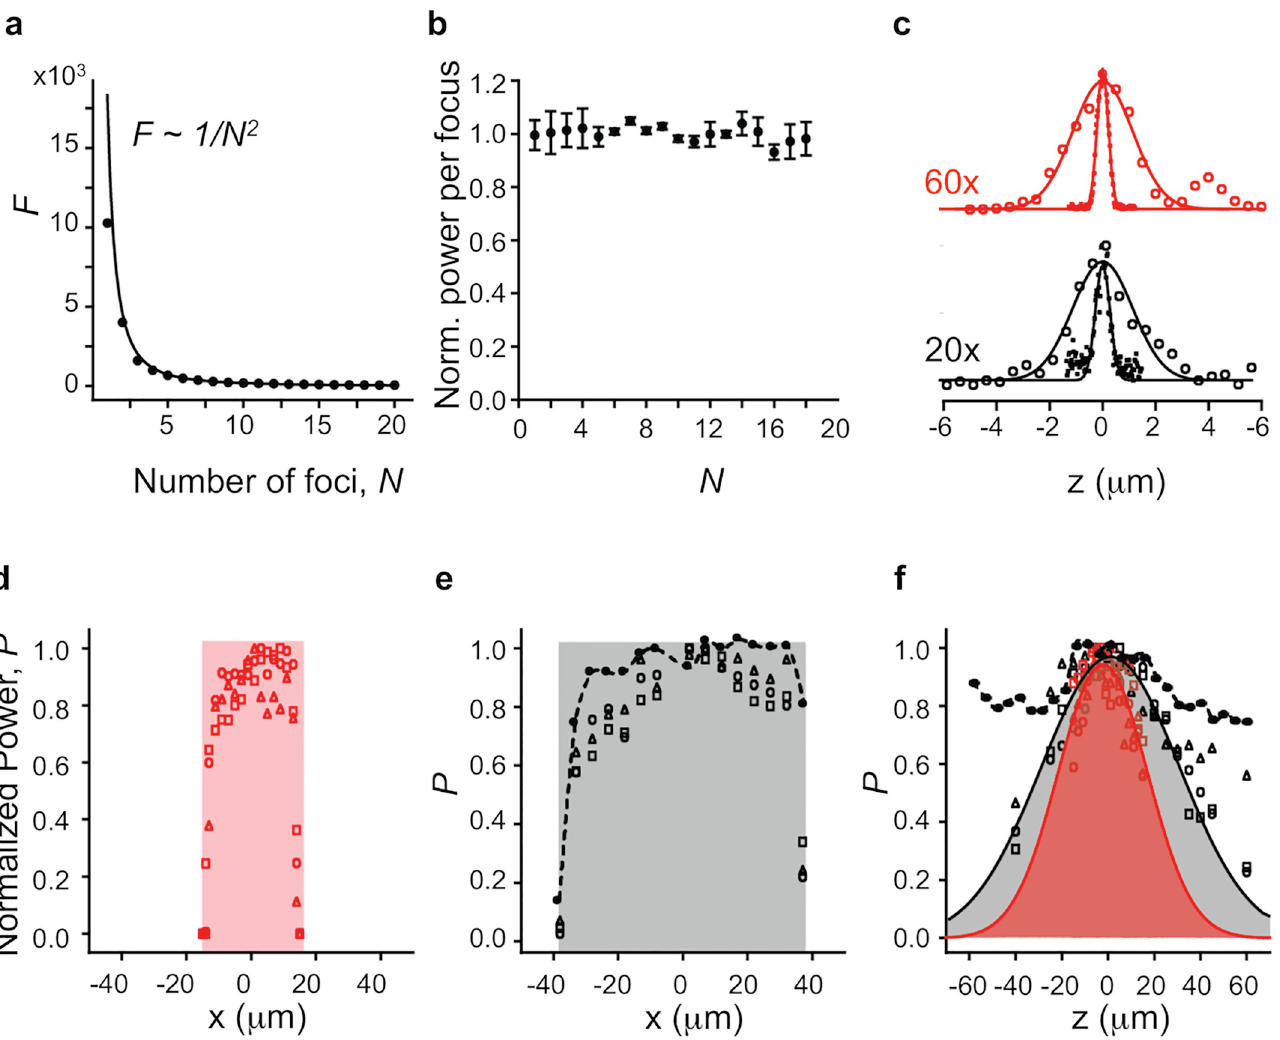
Fig 3. Performance of the holographic system. a : Normalized fluorescence intensity of a focal spot as a function of number of spots, N b : Normalized uncaging power per spot as a function of number of stimulation spots. Number of foci is kept constant and superfluous foci are moved outside of the holographic FOV in transverse direction. c : Measured PSF of two-photon excitation in the axial ( ⚬ ) and transverse ( ● ) directions for 60 × and 20 × objective lenses. d : Normalized power as a function of displacement along the x for 60 × for FOV centered at (0, 0) ( ⚬ ), ( − 100, − 100) μ m ( 4 ) and (100, 100) μ m ( □ ). e : Normalized power as a function of displacement along the x for 20 × for FOV centered at (0, 0) ( ⚬ ), ( − 300, − 300) μ m ( 4 ) and (300, 300) μ m ( □ ). Filled circles with dashed line denote power distribution after amplitude weighting for FOV centered at (0, 0). f : Normalized power as a function of displacement along the z for 60 × (red markers in red area) and 20 × (black markers in gray area) for FOV centered at different coordinates specified in d and e . Solid lines denote empirical Gaussian fit used for amplitude weighting. Filled circles with dashed line denote power distribution for 20 × after amplitude weighting for FOV centered at (0,